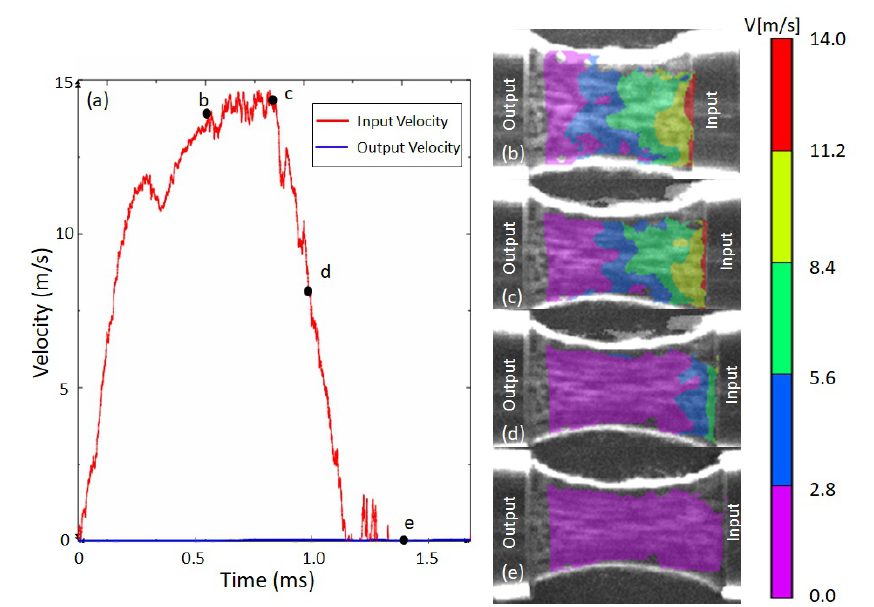
Figure 8. Validation of DIC measurements. ( a ) Velocities at the input and output interfaces registered by the strain gauges. Corresponding contour plots of longitudinal velocities at ( b ) t = 0.6 ms, ( c ) t = 0.8 ms, ( d ) t = 1.0 ms and ( e ) t = 1.4